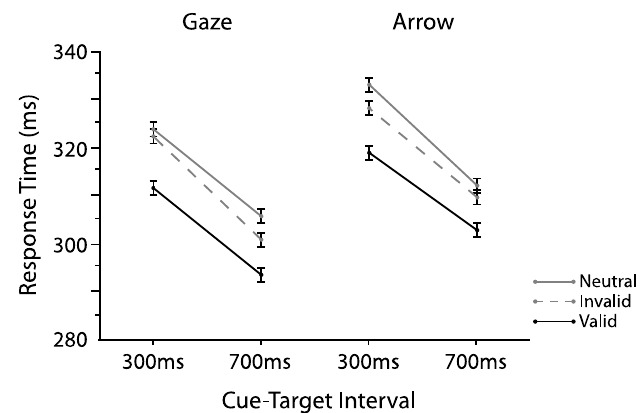
Figure 2. Mean response times (RTs) as a function of cue type, cue validity, and cue-target interval for Experiment 1. Error bars denote the standard error of the difference between the means.